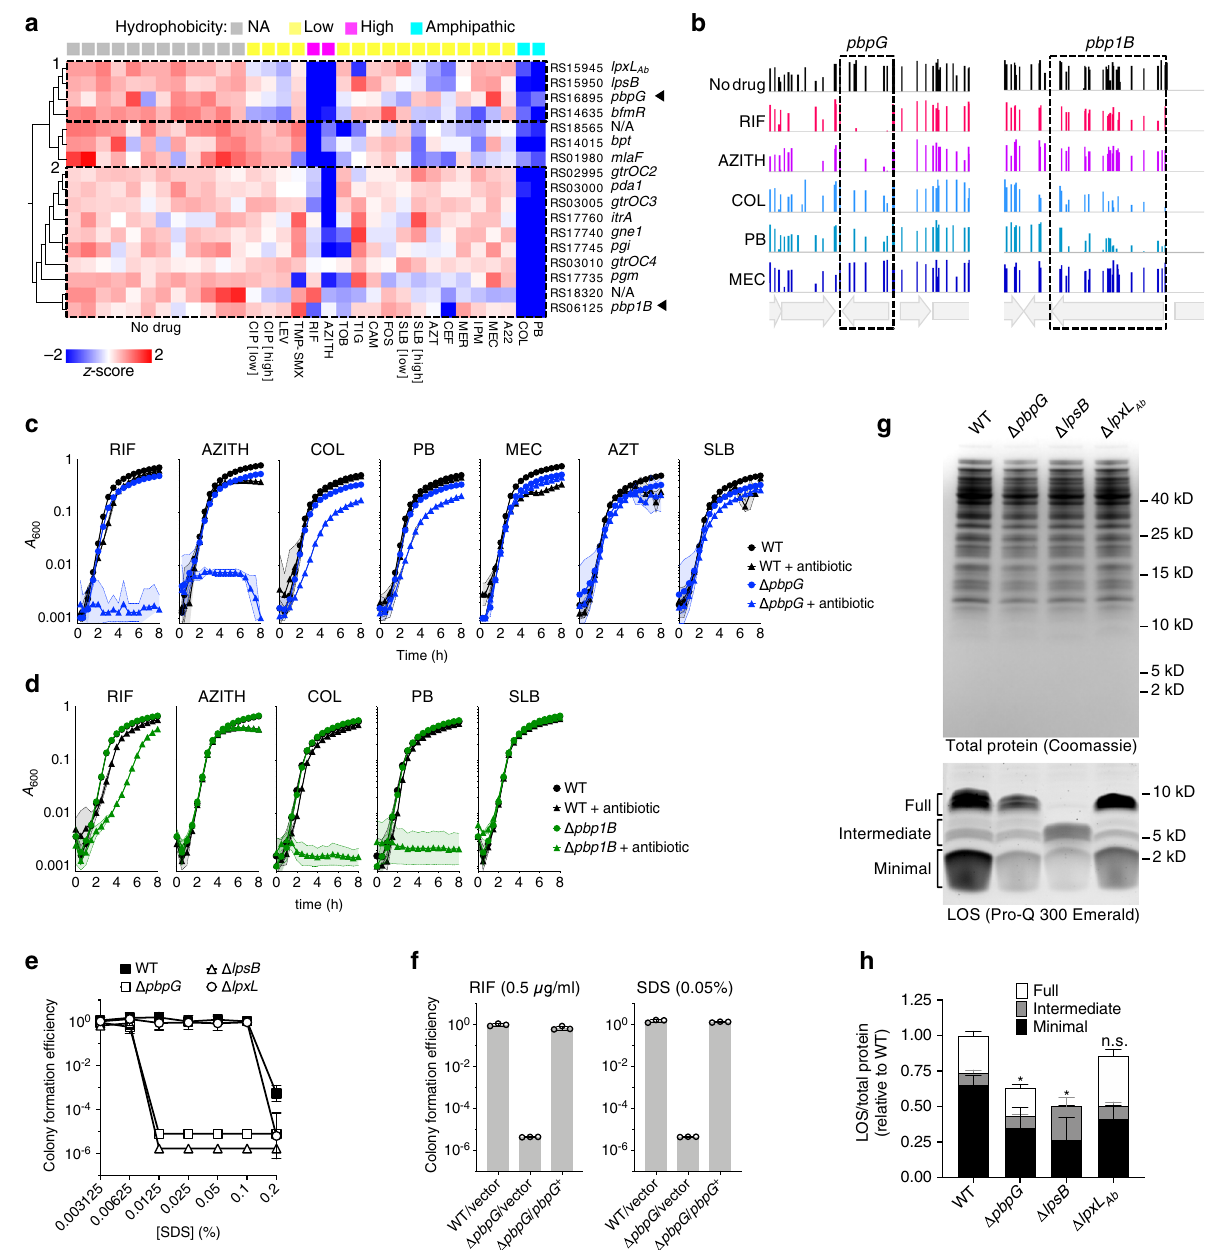
Fig. 4 Phenotypic signatures de fi ned by hydrophobic compound sensitivity reveal connection of pbpG to LOS synthesis. a Fitness pro fi le clusterogram of genes for which knockout causes preferential but differing hypersensitivity to hydrophobic (RIF and AZITH) and amphipathic (COL and PB) antibiotics. Tn-seq data were subjected to PCA to identify discriminating genes whose fi tness values differed as a function of hydrophobicity annotation [high, xlogp3 ≥ 4; low, xlogp3< 4; amphipathic, polymyxin antimicrobial peptides; NA not applicable (no drug); Supplementary Table 1] (ANOVA, q = 0.0003). Heatmap shows normalized fi tness in z -scored units. Dashed boxes indicate clusters of phenotypic signatures de fi ned by differential defects with hydrophobic and amphipathic drugs. Arrowheads highlight cell-wall enzymes clustering with distinct surface polysaccharide synthesis pathways. b Bars show fi tness values of individual transposon mutants at each locus across all tested banks as in Fig. 3. c , d Validation of Tn-seq selective drug hypersensitivities using deletion mutants Δ pbpG ( c ) or Δ pbp1B ( d ) vs. isogenic WT. Data points show geometric mean ± s.d. ( n = 3 independent cultures, except for WT + MEC, n = 2 independent cultures) as in Fig. 3. e Δ pbpG strain shows detergent hypersensitivity phenotype matching that of lpsB LOS glycosyltransferase mutant by colony formation ef fi ciency (CFE) assay. Data points show geometric mean ± s.d. ( n = 4 independent cultures). f Reintroduction of pbpG reverses hypersusceptibility to RIF and SDS. Strains harbored vector (pYDE153) or vector containing pbpG (pYDE210). Bars show geometric mean CFE ± s.d. ( n = 3 independent cultures). g , h pbpG knockout results in reduced LOS levels. g LOS (bottom) and total protein (top) were detected in cell lysates separated by SDS-PAGE. Image is representative of three experiments. h LOS levels in regions indicated in g were normalized to total protein content. Values are shown relative to total normalized LOS levels in WT. Bars show mean ± s.d. from n = 7 (WT, Δ pbpG ) or n = 5 ( Δ lpsB and Δ lpxL ) biologically independent samples. Total normalized LOS levels of each mutant were compared to WT by two-way ANOVA with Dunnett ’ s multiple comparisons test. * p < 0.0001; n.s. not signi fi cant ( p = 0.1652). Source data are provided as a Source Data fi